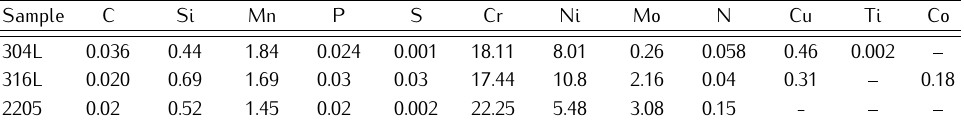
Table 1. Composition of steel